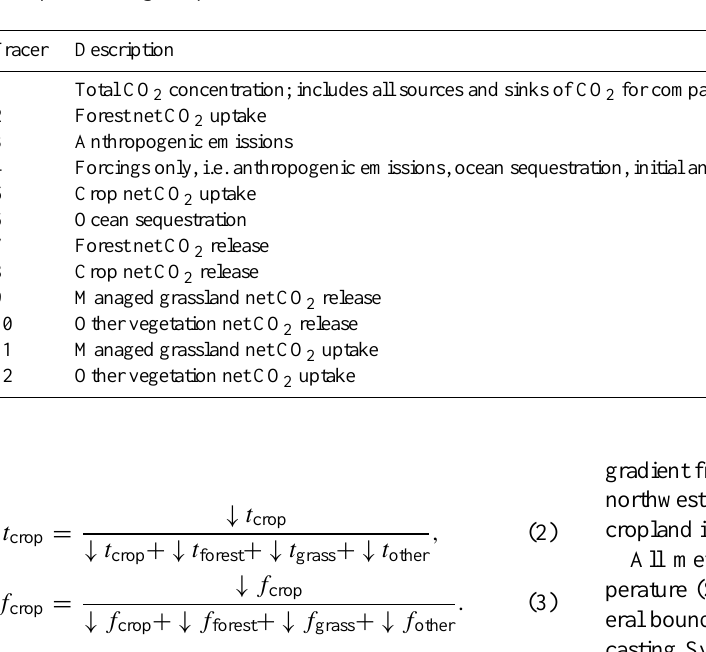
Table 1. Tracer pools and definitions used by WRF-SPA. A non-interacting tracer does not have the potential to be exchanged with the land surface after its initial emission. An interacting tracer can be removed from the atmosphere as it represents a physical mass of CO 2 added to the atmosphere through